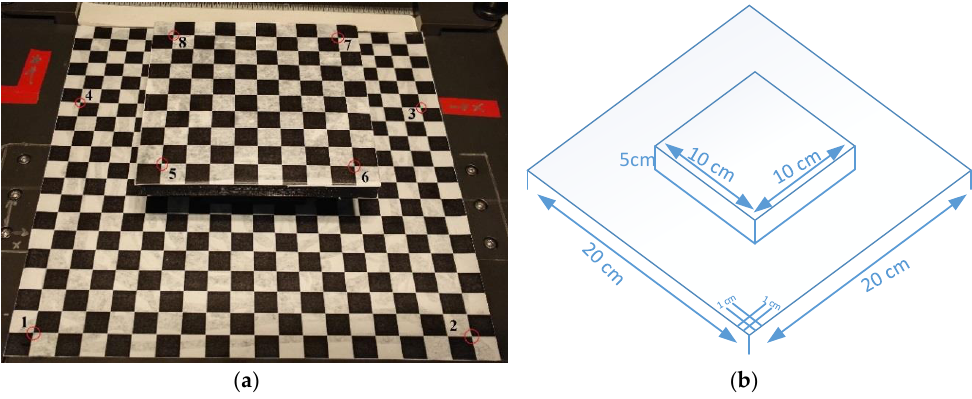
Figure 2. ( a ) Reference gauge with a regular chess pattern with 1 cm edge length, red circles are the selected reference points numbered from 1 to 8; ( b ) Technical drawing with size specifications.